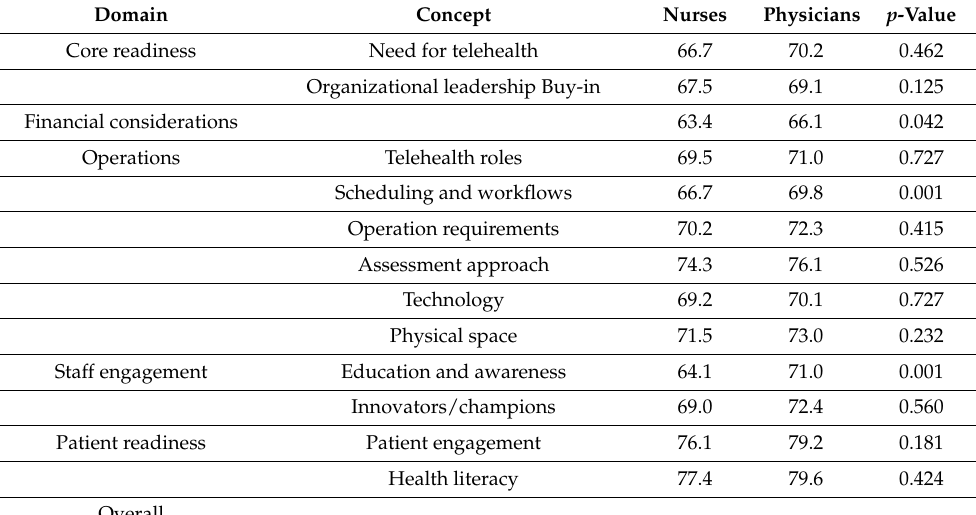
Table 2. Differences in ratings of healthcare providers regarding telehealth readiness.